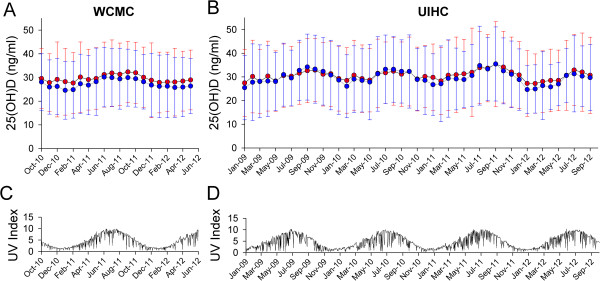
25(OH)D immunoassay – average concentration by order month with regional UV index. A,B. Average 25(OH)D results at WCMC (A) and UIHC (B) by sex [female = red circles; male = blue circles] and order month. Error bars are ± SD. C,D. Daily issued UV Index for New York City, NY (C) and Des Moines, IA (D) (see Methods).